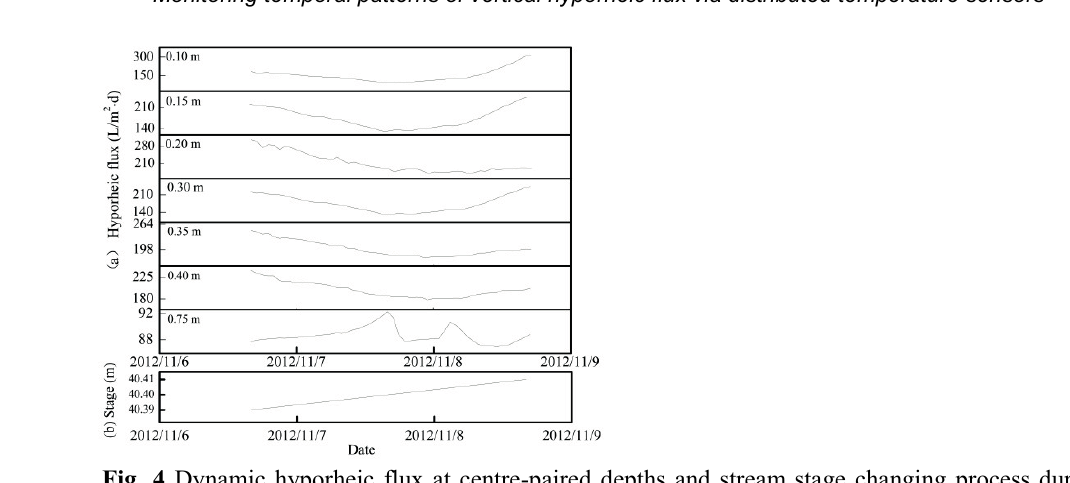
Fig. 4 Dynamic hyporheic flux at centre-paired depths and stream stage changing process during the monitoring period.